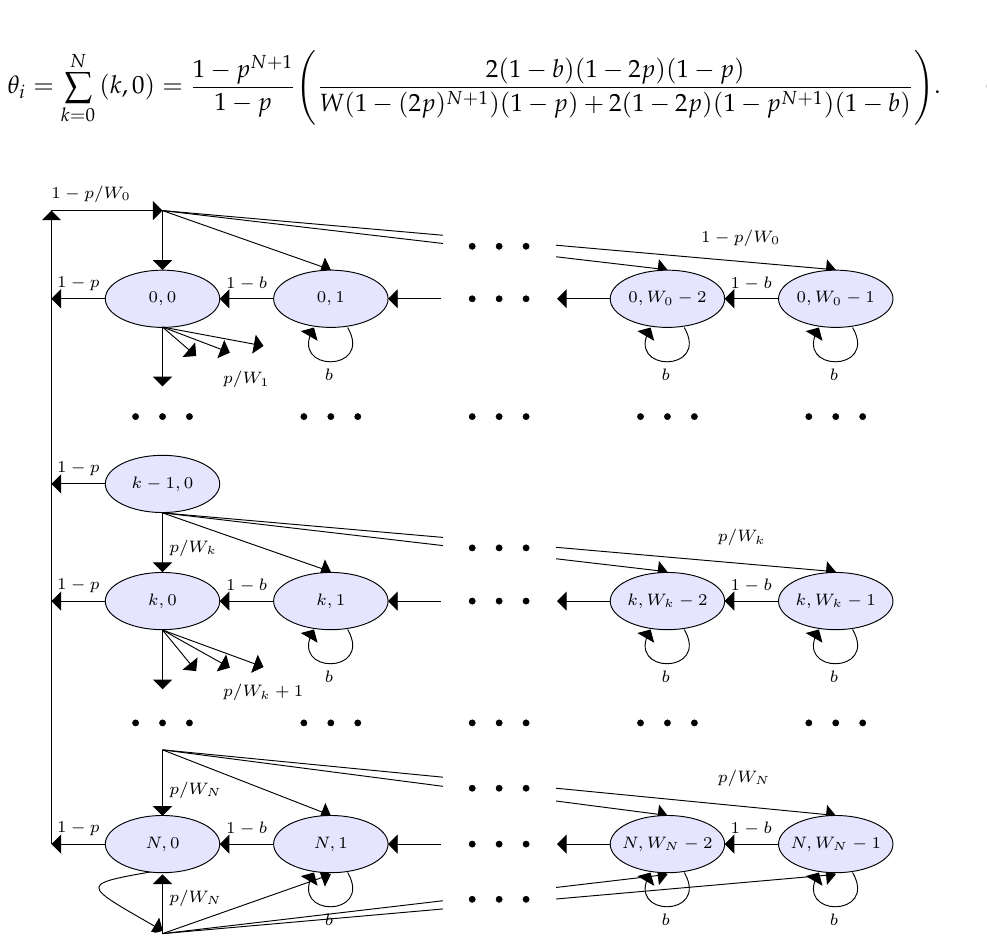
Figure 5. Markov model for the backoff process in